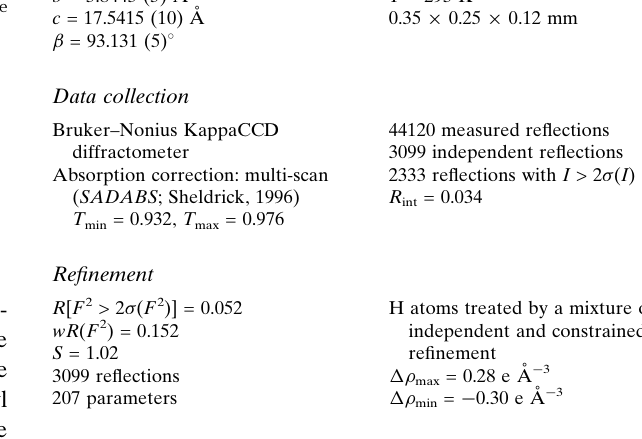
Bruker–Nonius KappaCCD diffractometer